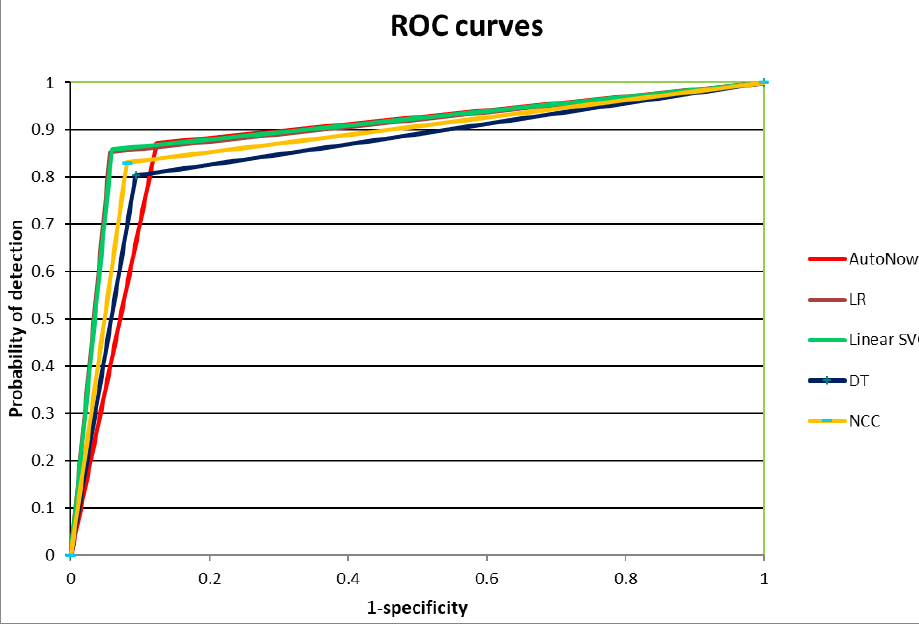
Figure 8. ROC curves for the classifiers from Table 4 on MET data